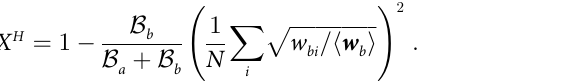
Fig 2. Comparison of analytical and numerical results for optimal influence allocations on the continuous regime. Each panel show the dependence of optimal allocations w ai on the allocations of a passive controller w bi when the value of external allocations are generally a lower, b equal, or c higher than node degrees, as shown on the top of each panel. The active controller is in budget superiority ( B with weights randomly drawn from a uniform distribution. Numerical results are given by a cloud of points resolved by classes of nodes of different degrees, indicated by their colour, and analytical results are given by black curves that correspond to Eq (5) ( solid ) or Eq (7) ( dashed ).